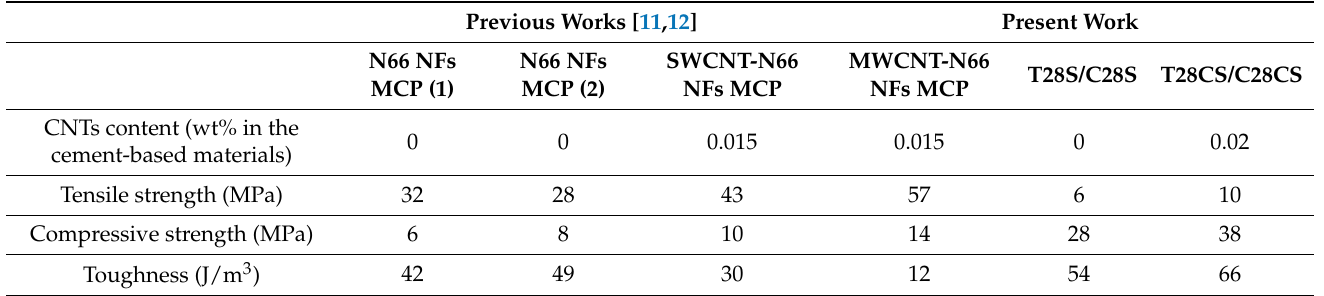
Table 6. Effectiveness of TEOS/PVP NFs, CNT-TEOS/PVP NFs, N66 NFs, and CNT-N66 NFs on mechanical properties of cement pastes (increase in % compared with parameters of control